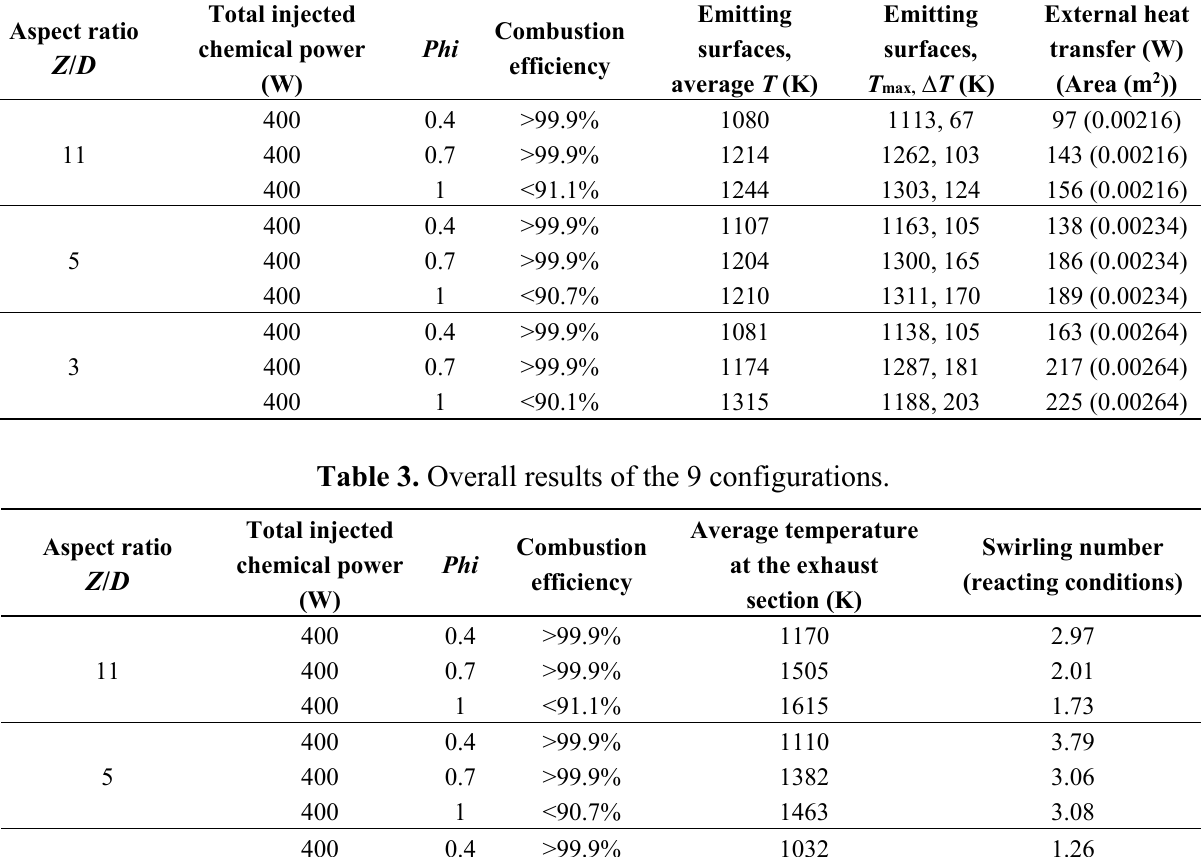
Table 2. Overall results of the 9 configurations.